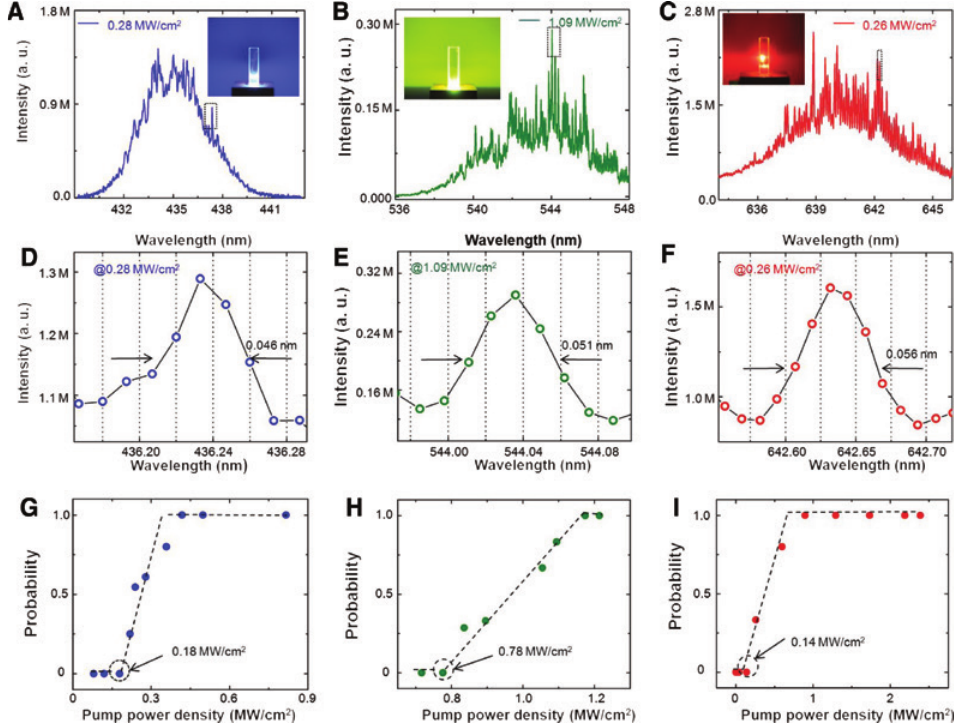
Figure 6: Performance of colorful random lasers. (A–C) Emission spectra from RL-C440, RL-C153, and RL-Oz under different pump power densities. The inset is the corresponding photograph of RL-C440, RL-C153, and RL-Oz. (D–F) Magnifying emission spectra of RL-C440, RL-C153, and RL-Oz. (G–I) Threshold behavior of RL-C440, RL-C153, and